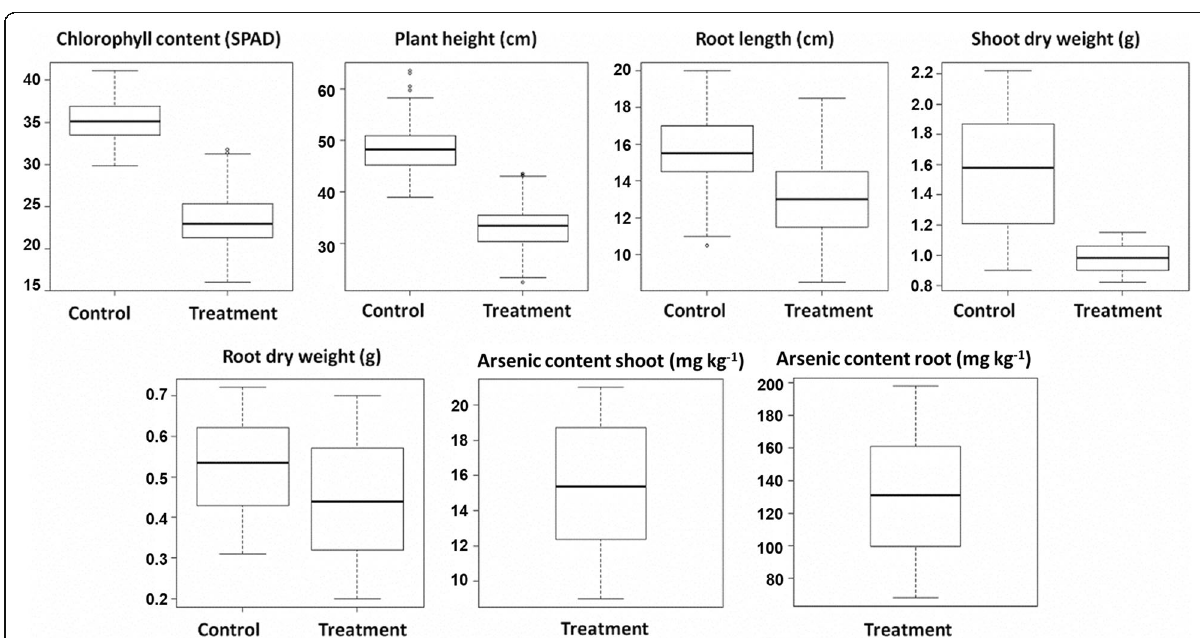
Fig. 2 Box plot distribution of measured As-related stress in the population; control with no As and treatment with 10 ppm As a substitution for 18 days. Control: without As substitution, Treatment: with 10 ppm As